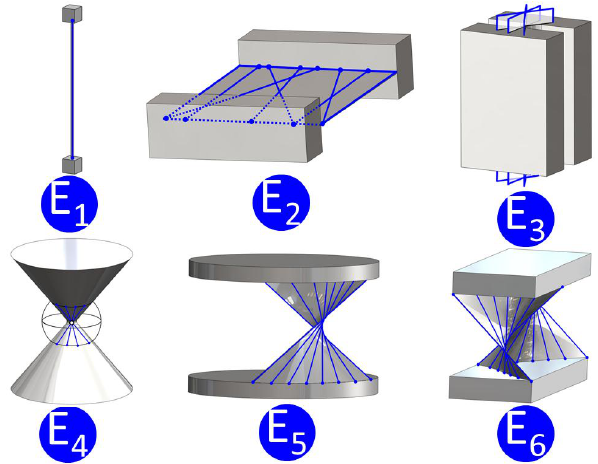
Figure 2. Parallel flexure element examples.